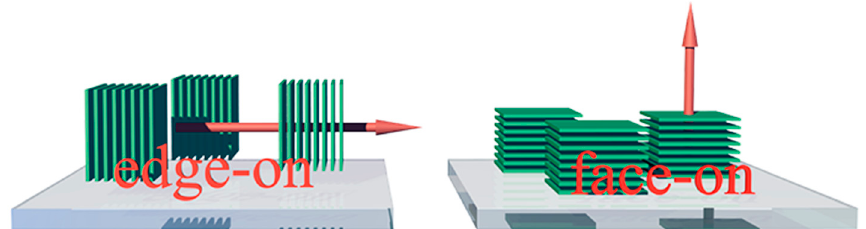
Figure 3. The configuration of molecules in edge-on ( left ) and face-on ( right ) stackings. The red arrow indicates the preferred charge carrier transport direction.